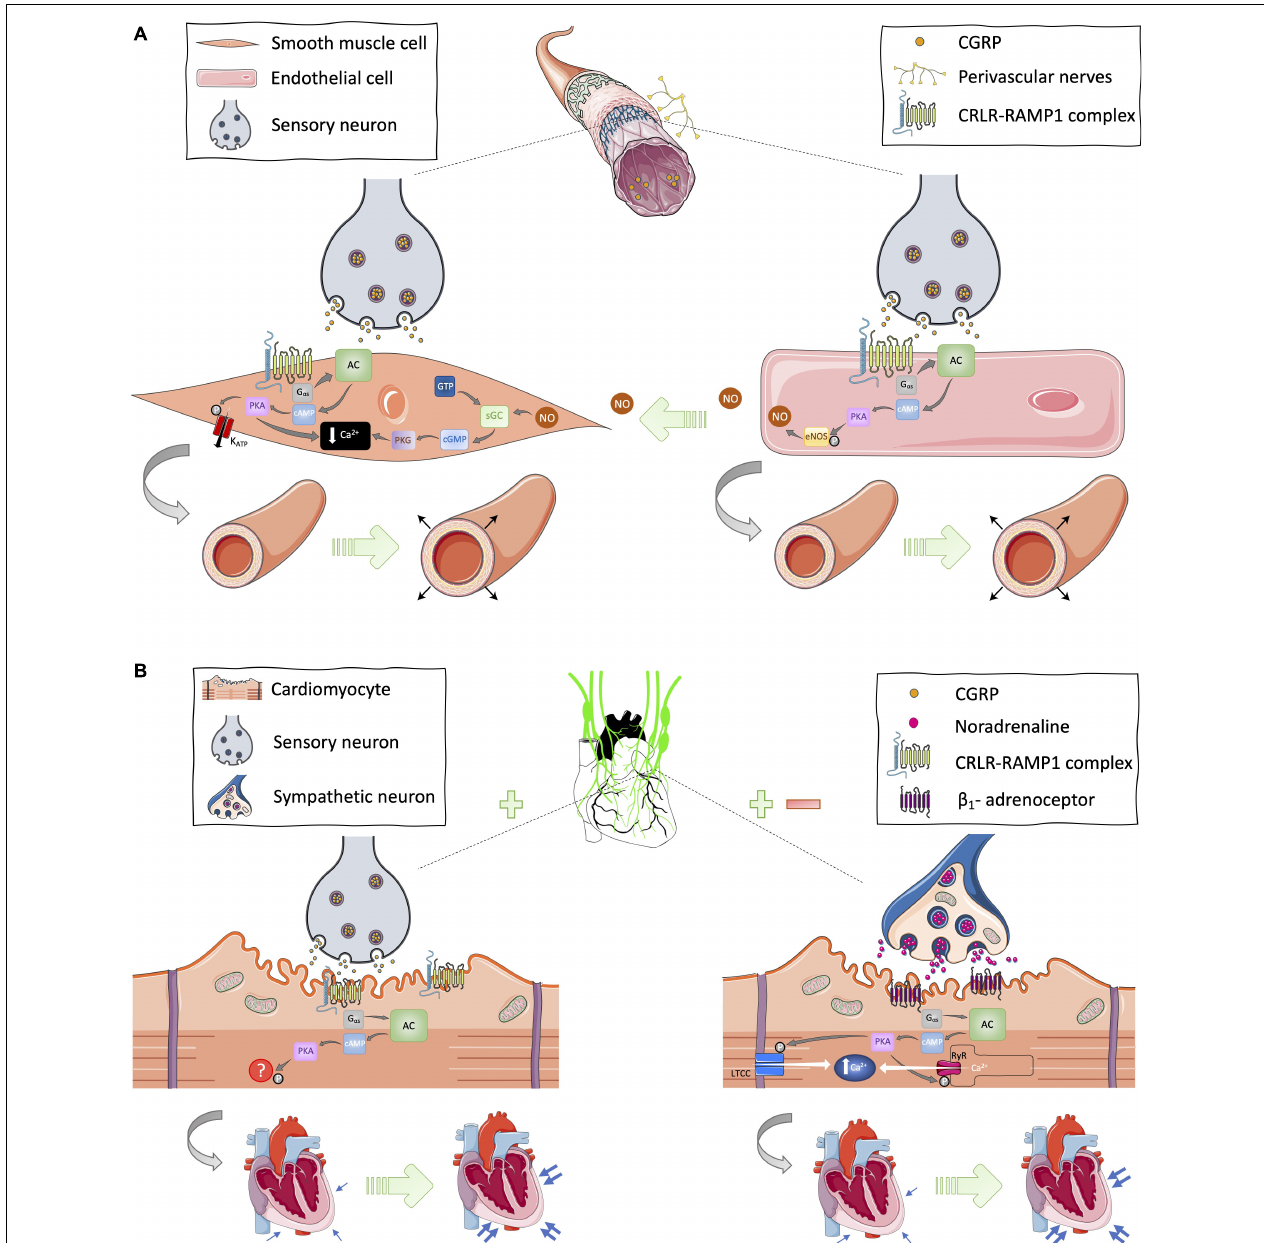
FIGURE 1 | Proposed cardioprotective mechanisms of CGRP in the (A) vasculature and (B) myocardium. (A) In the vasculature, CGRP circulating in the blood or released from sensory neurons can bind on to its canonical receptor, the CRLR-RAMP1 complex, expressed in the plasma membrane of vascular smooth muscle and endothelial cells to initiate G α s -protein signal transduction and subsequently cause relaxation of smooth muscle cells via nitric oxide (NO)-dependent and -independent mechanisms thus leading to vasodilation. (B) In cardiac tissues, there is evidence for CGRP-stimulated modulation of sympathetic outflow and expression of the CRLR-RAMP1 complex on cardiomyocytes. Hence, CGRP has the potential to induce G α s -protein signaling from sensory and sympathetic nerves leading to increased cardiac contractility, thus positive inotropy and chronotropy. AC, adenyl cyclase; cAMP, cyclic adenosine monophosphate; cGMP, cyclic guanosine monophosphate; eNOS, endothelial nitric oxide synthase; GTP, guanosine triphosphate; K ATP , ATP-sensitive potassium channels; LTCC, L-type calcium channel; NO, nitric oxide; P, phosphate; PKA, protein kinase A; RyR, ryanodine receptor; sGC, soluble guanylate cyclase. [Images were obtained